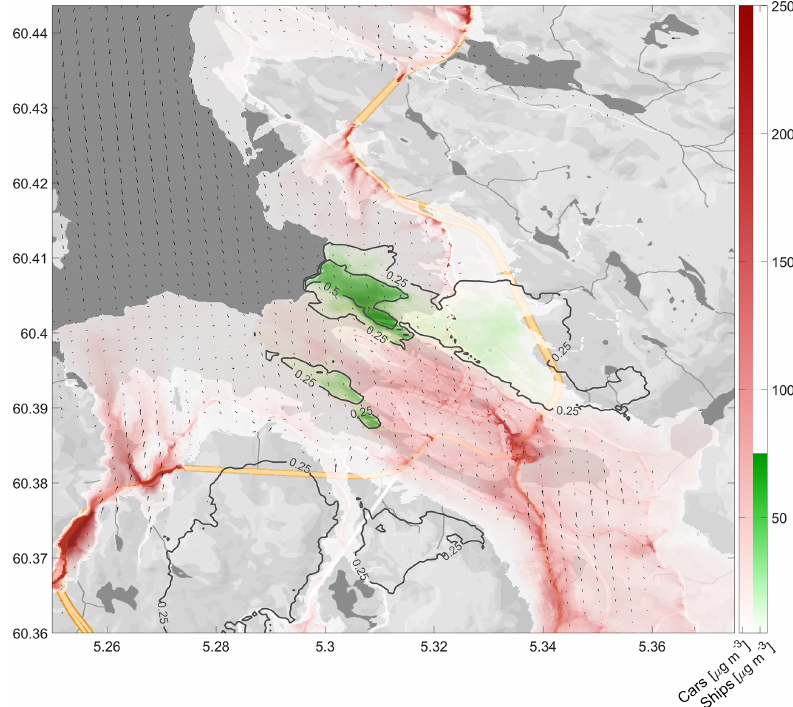
Figure 11. The same as in Fig. 7 but for the scenario ws03_wd02_ft03. The concentrations are given by semi-transparent colour shading overlaying the grayscale land and water surface taken from map data ©2019 Google.